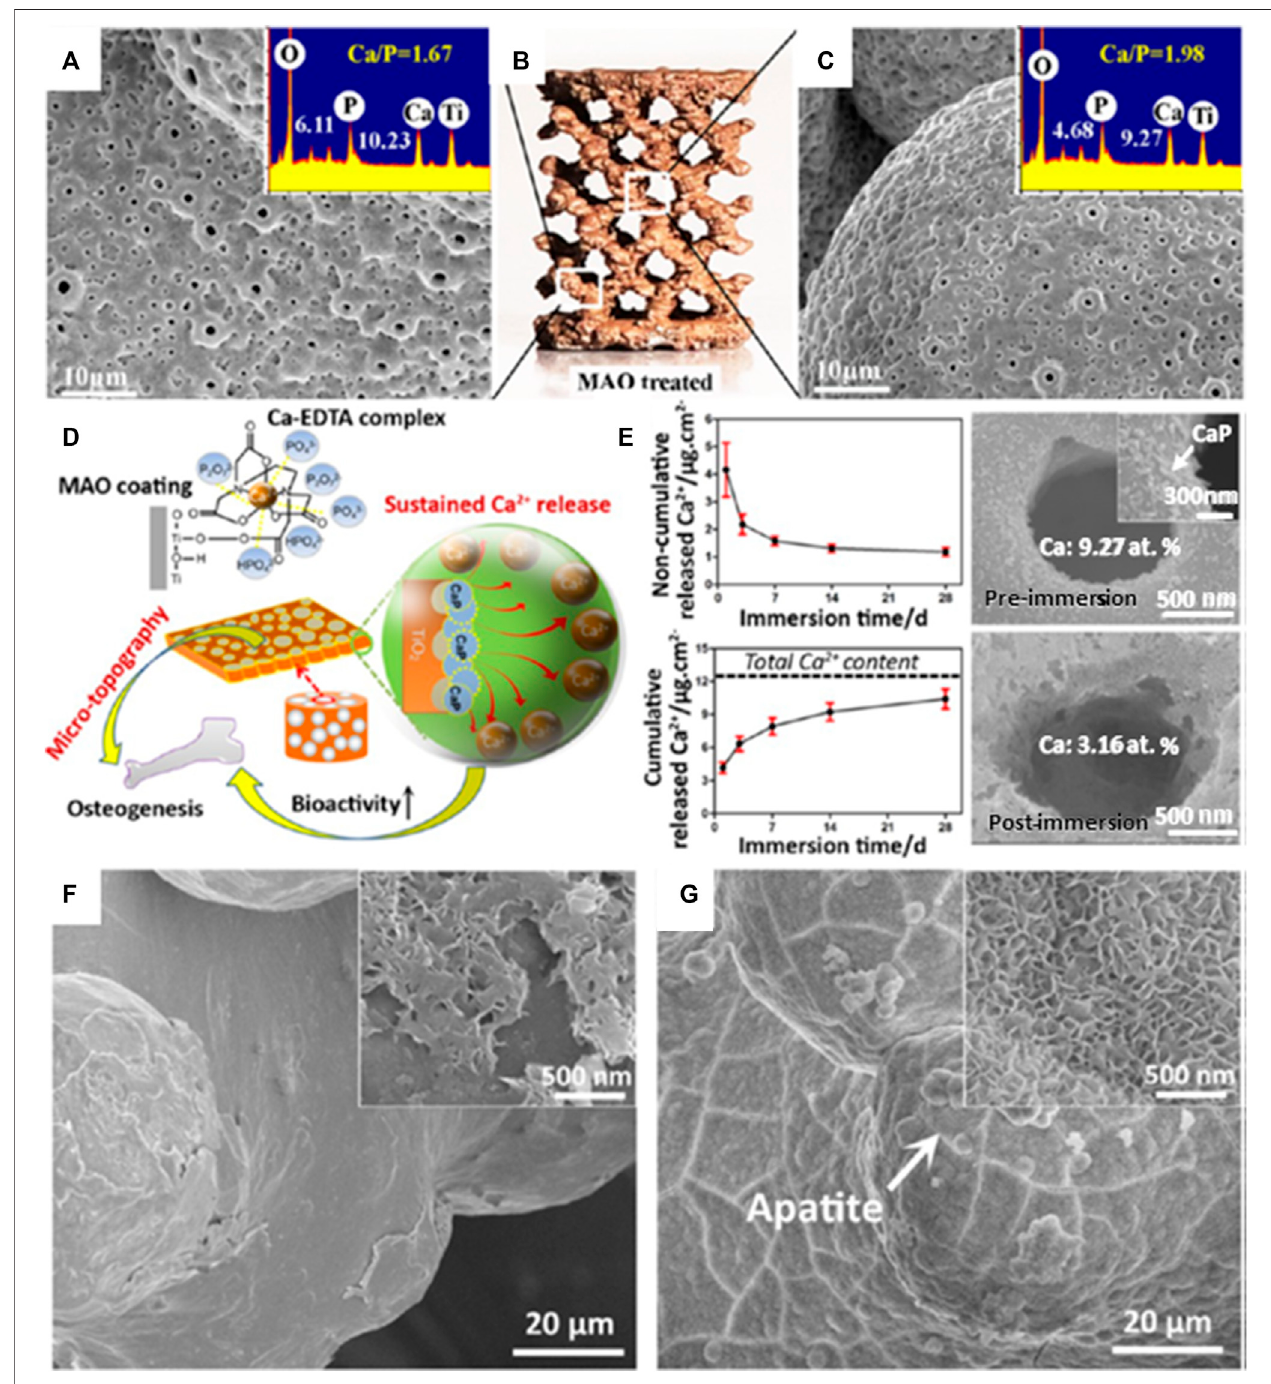
FIGURE7| Computer-aideddesign(CAD)modelofmultiplanarhexagonalunitcellstructureswithamacroscopicalviewofanMAO-treatedscaffold (B) ;theMAO- treated scaffold at the (A) outer surface and (C) central surfaces. (D) The illustrative diagram shows the simultaneous generation of microporous topography and bioactive elements on the macroporous scaffold by MAO treatment in a Ca-Ethylenediaminetetraacetic acid (EDTA) – containing electrolyte and (E) the noncumulative and cumulative release curves of Ca 2+ in phosphate-buffered saline (PBS) for 28 days; scanning electron microscope (SEM) images of the implant surface before and after immersion for 28 days are shown on the right side. (F) SEM image of the untreated porous Ti64 scaffold immersed in stimulated body fl uid (SBF) for 14 days and (G) SEM image of the MAO-treated scaffold immersed in SBF for 3 days. Image reproduced from Xiu et al. (2016).